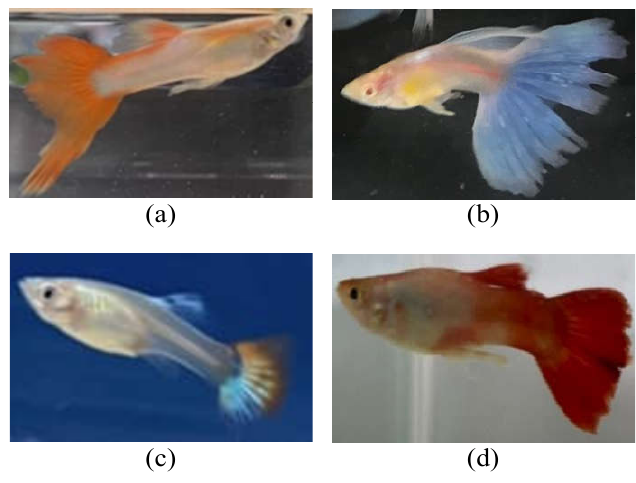
Figure 1. Illustration of guppy fish ( a – d ).